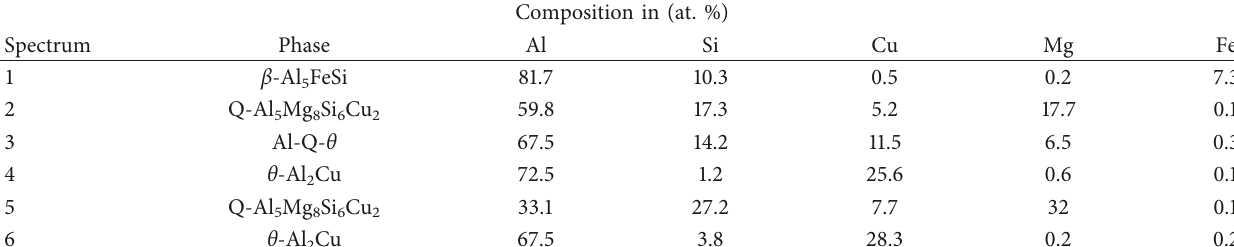
Table 3: Composition of the located intermetallic phases as measured by semiquantitative EDS. Composition in (at. %)